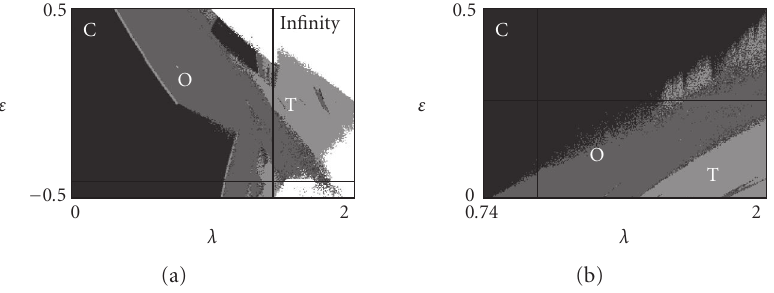
Figure 3.4. Phase diagrams for globally coupled maps without pacemaker for pure dissipative (a) and pure inertial (b) couplings. Letter C means coherent phase, letter O means ordered, and letter T—turbulent